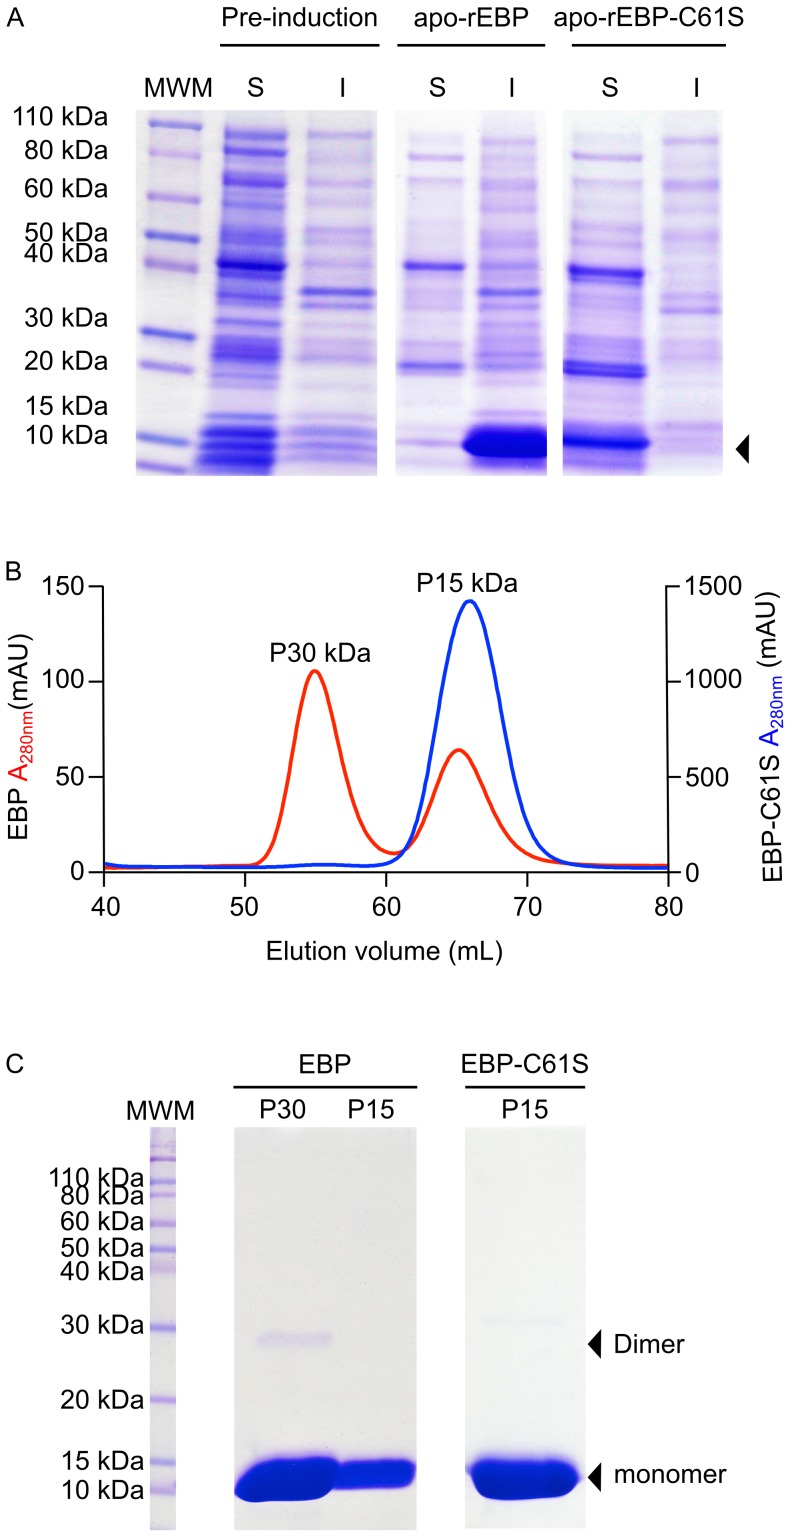
Expression and purification of recombinant apo-EBP and apo-EBP-C61S.Apo-rEBP and apo-rEBP-C61S were produced using E.coli expression strain BL21(DE3), Expression levels were evaluated on reducing 1D SDS-PAGE, prior to induction and 6 h post-induction, A. Soluble (S) and insoluble (I) fractions of bacterial cell lysate are indicated. Arrowhead indicates the position of EBP and EBP-C61S bands, the identities of which were confirmed by mass spectrometry (Figure S1). Apo-rEBP and apo-rEBP-C61S were purified from the soluble fractions of the bacterial cell lysates. Gel-permeation chromatography was performed under non-reducing conditions for the final stage of purification on a 16/60 Sephacryl S-100 column, with the effluent monitored at 280 nm, B. Apo-rEBP is shown on the left y-axis (red) and apo-rEBP-C61S on the right y-axis (blue). The molecular weight of the eluting species was estimated with reference to the manufacturers Sephacryl S-100 column standard curve. The fractions within each peak were pooled and a 10 µL aliquot of each was analyzed on reducing 1D SDS-PAGE, C. The positions of the monomeric and dimeric forms of protein are indicated by black arrowheads.